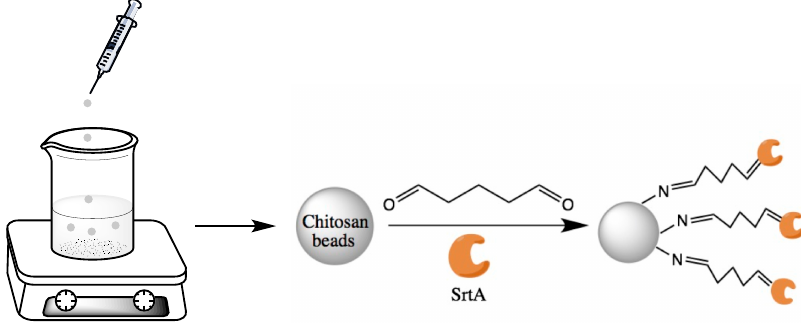
Figure 7. Scheme of preparation of chitosan particles and SrtA immobilization.